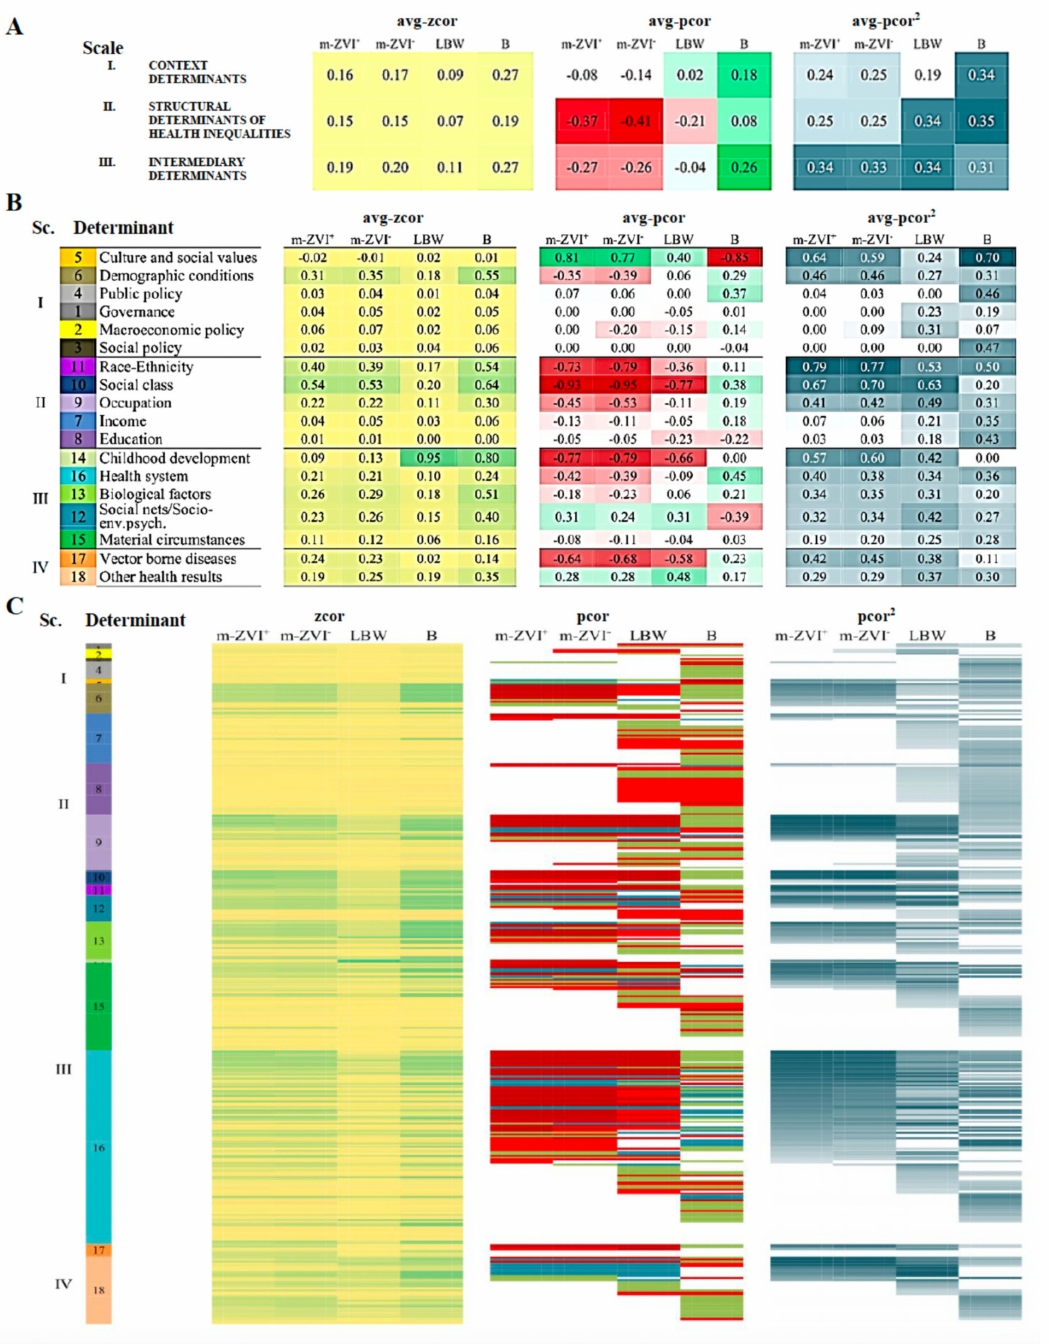
Figure 4. General pattern of factors associated microencephaly is unspecific for microcephaly in- cidence positive for Zika infection (m-ZIKV + ) and these factors explain the nonspecific pattern of associations of m-ZIKV + . See text for